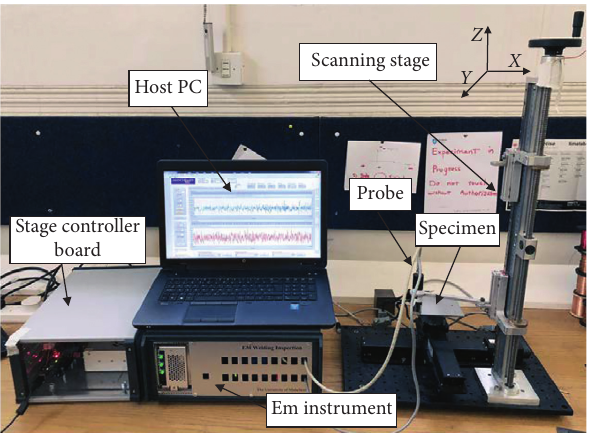
Figure 4: ECT instrument.